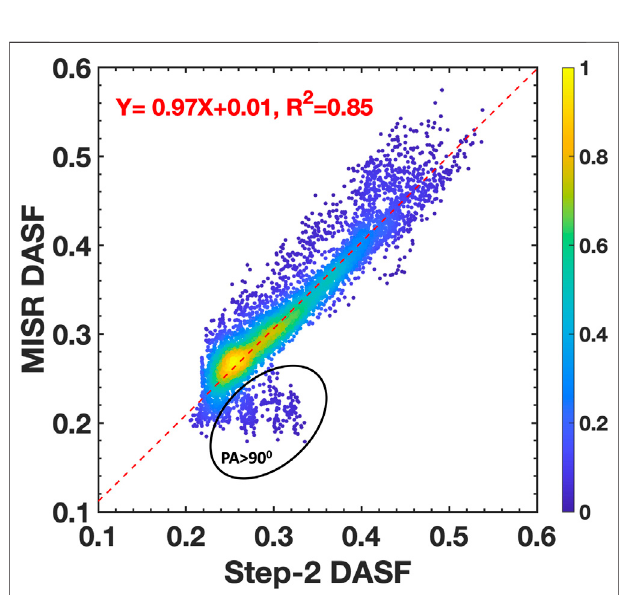
FIGURE 4 | MISR DASF vs . its Step-2 approximation accumulated over our study area during the 2017 to 2019 period. NRMSE (cid:2) 8%; R 2 (cid:2) 0.85. The ellipse separates values of DASF at Phase Angles (PA) above 90 0